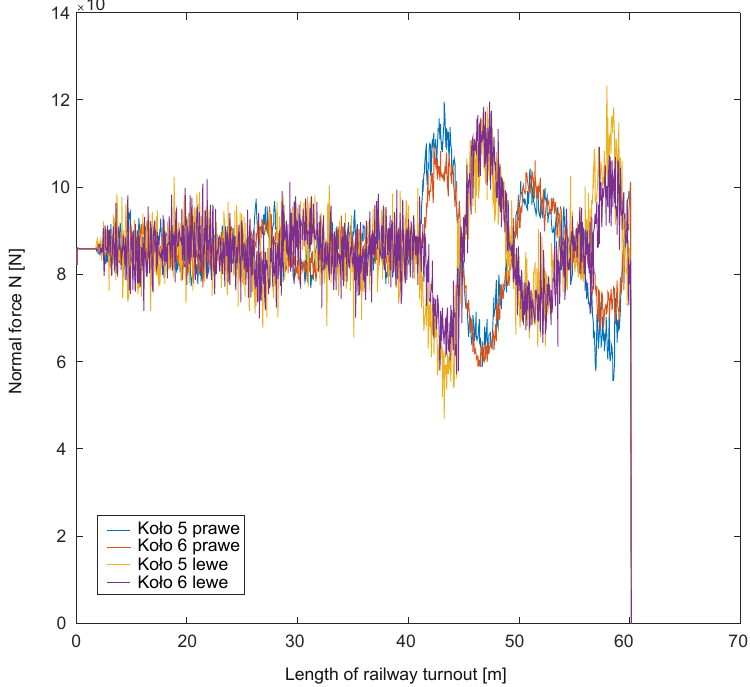
Figure 16. Normal force at 300 km/h on a straight track through a turnout.